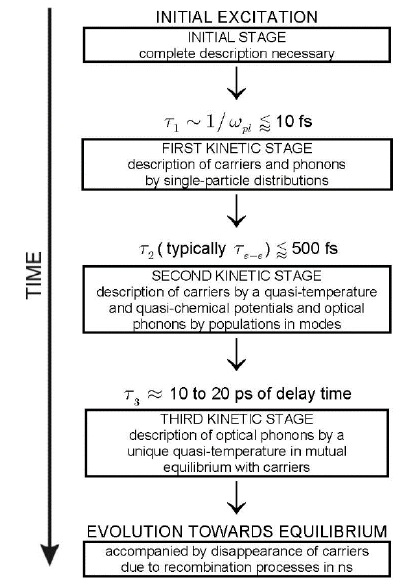
Figure 3. Schematic description of the successive kinetic stages in HEPS along its evolution in a pump-probe